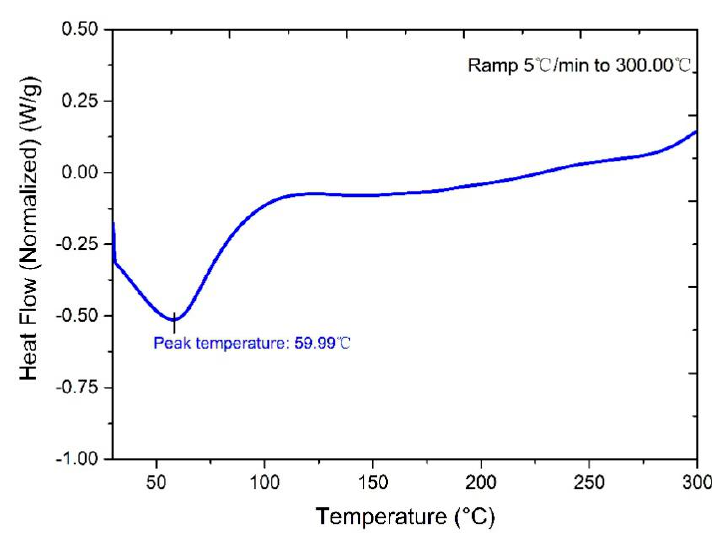
Figure 1. Differential scanning calorimetry (DSC) graph of straw core material.